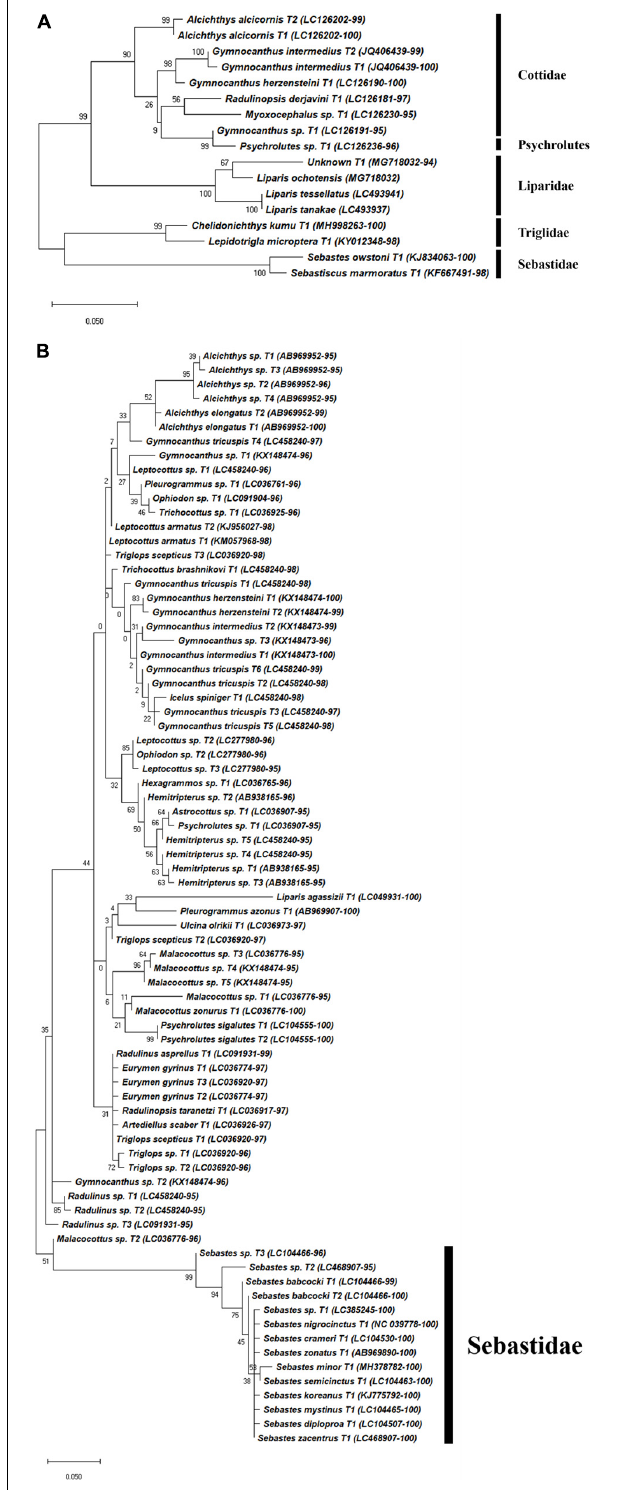
FIGURE 5 | Phylogenetic analysis of representative Scorpaeniformes haplotypes generated by (A) FishU primers and (B) MiFish primers. Phylogenetic tree was constructed by maximum-likelihood algorithm (MEGA-X) under 1000 bootstrap